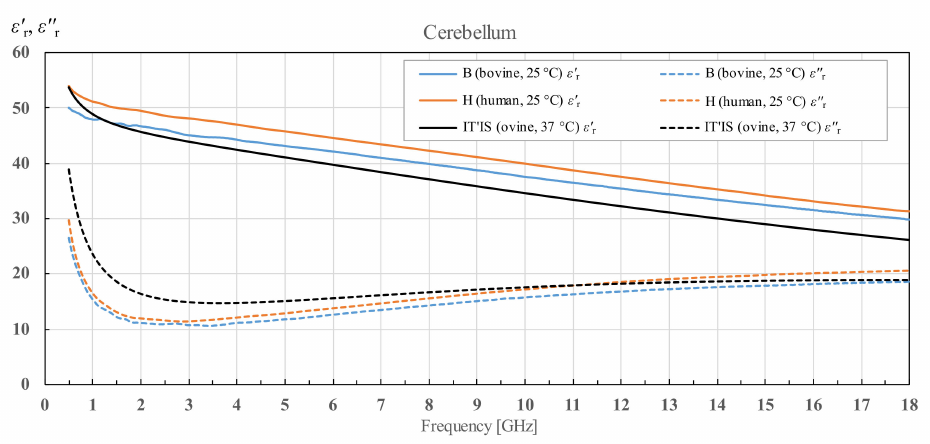
Figure 20. Cerebellum permittivity comparison of bovine brain (B1) and averaged human brains (H), as well as comparison with the published data from IT’IS database [21].